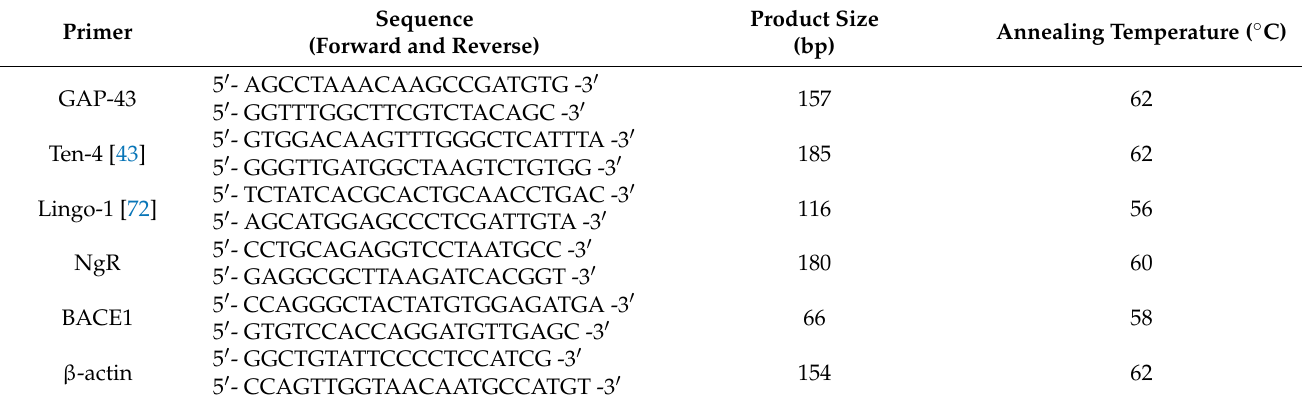
Table 5. Primer sequences, product sizes, and annealing temperatures used for quantitative real-time